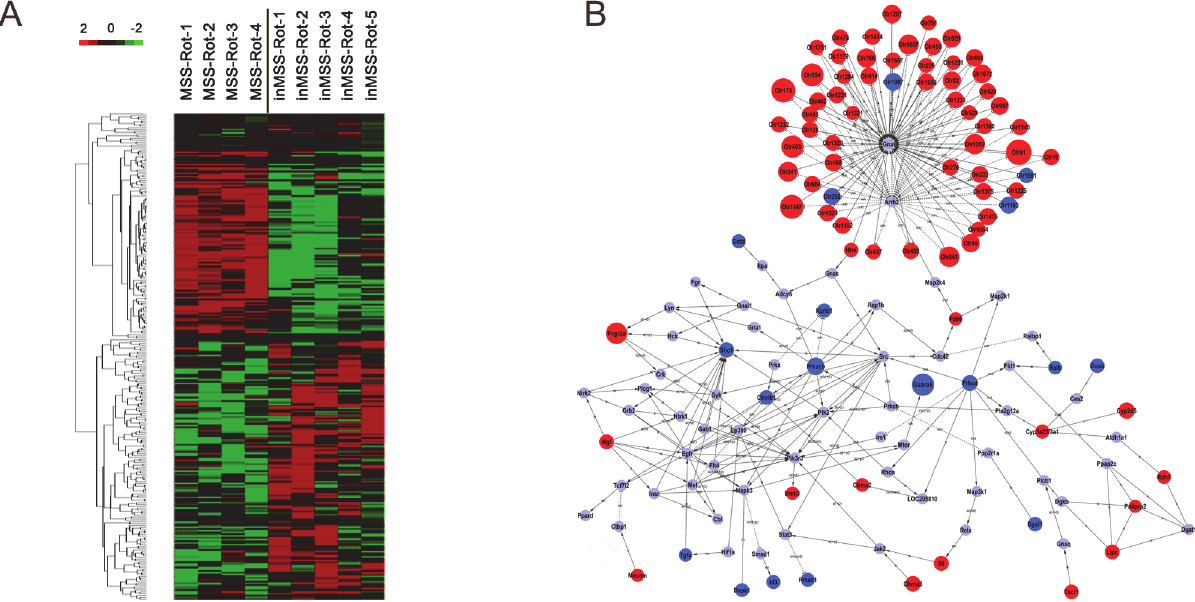
Fig 3. Hierarchical clustering of the signal value and signaling regulatory network of the differentially expressed genes. (A)Heat map of differential changes in gene expression between MSS-Rot and inMSS-Rot animals. The dendrogram was produced by hierarchical clustering of the signal value of differentially expressed genes in MSS-Rot rats (n = 4, left) and inMSS-Rot samples (n = 5, right). Colorimetric scaling of standardized gene expression values ranging from low (green) to high (red) is shown in the legend (upper left). (B) Signal-net of the differentially expressed genes. Red nodes and blue nodes represent up-regulated and down-regulated genes, respectively. Grey nodes represent intermediate genes functionally connecting the differentially expressed genes. Solid lines with arrow head indicate activation (a), dotted lines indicate inhibition (inh) and solid lines indicate binding (b) or expression regulation (ex). Node size represents the degrees of diiference in gene expression levels of MSS relative to